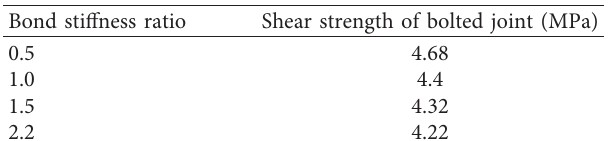
Table 6: Relationship between bond stiffness ratio and peak shear